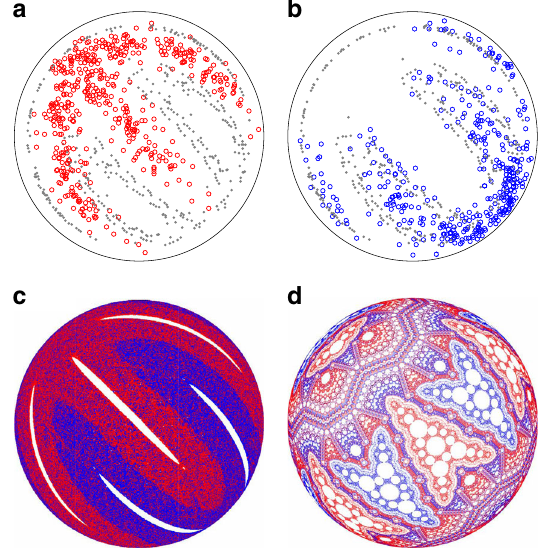
Fig. 6 Period-3 mixing barrier between two halves of the domain for the (45°, 45°) protocol. a , b In 500-iteration experiments, the tracer particle (red and blue circles) cycles through two distinct parts of the domain every three periods depending upon its initial location. c The corresponding FL model has two thin sets of period-3 islands corresponding to the structure in experiment ( a , b ) [red islands in c correspond to red ‘ fi ngers ’ in a and blue islands in c correspond to blue ‘ fi ngers ’ in b ]. The two sets of islands in experiment are separated by a mixing barrier (gray points in a , b which are extracted from the FL model). d The PWI model predicts two sets of period-3 arrowhead